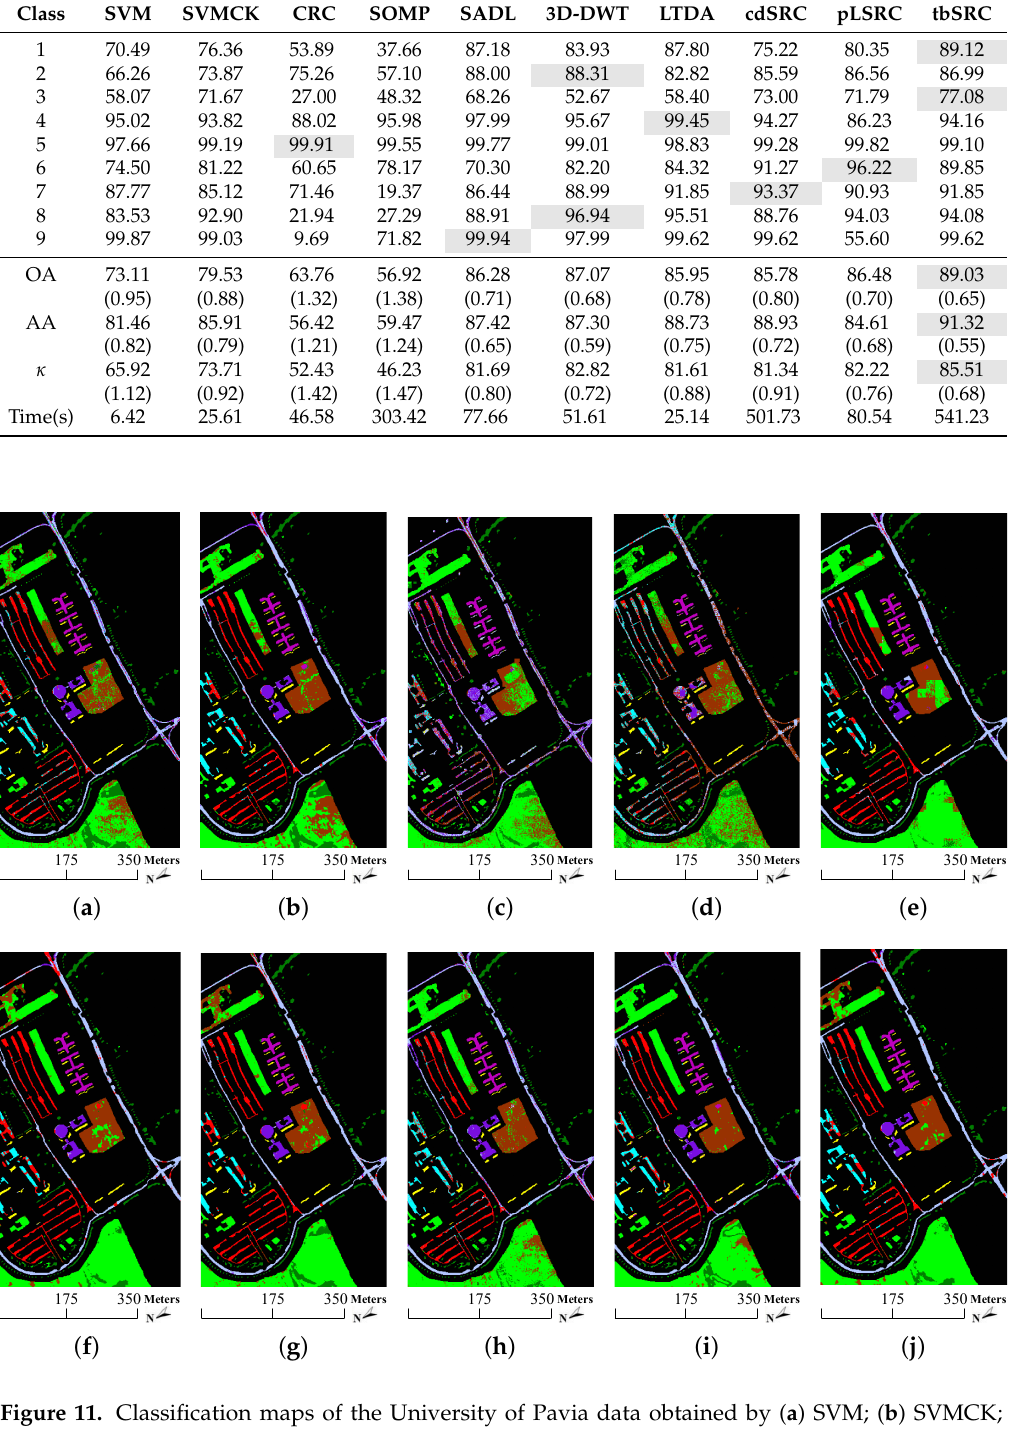
Figure 11. Classification maps of the University of Pavia data obtained by ( a ) SVM; ( b ) SVMCK; ( c ) CRC; ( d ) SOMP; ( e ) SADL; ( f ) 3D-DWT; ( g ) LTDA; ( h ) cdSRC; ( i ) pLSRC; and ( j )